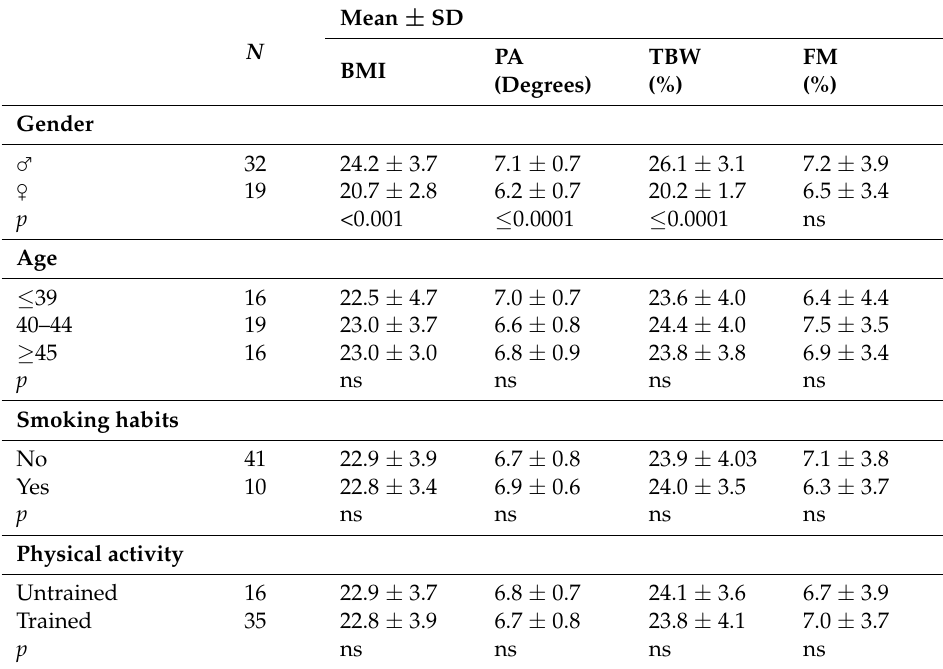
Table 1. ANOVA analysis of the impedance measures stratified by selected individual characteristics of the study population (ns = not